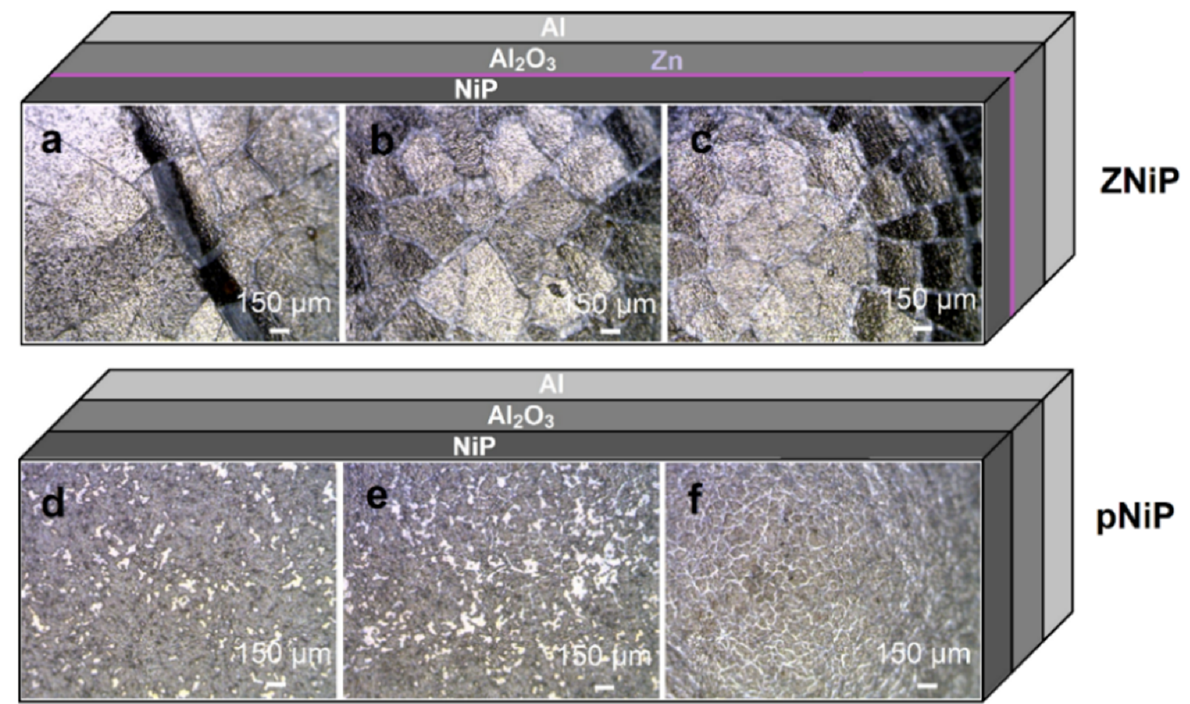
Figure 2. The ZNiP coating (deposited on NAC with zincate treatment) cracks or peels off completely at a hammer lift height of 10 cm (Figure 2a). Meanwhile, the pNiP coating (deposited on NAC without zincate treatment) does not change significantly (Figure 2d).